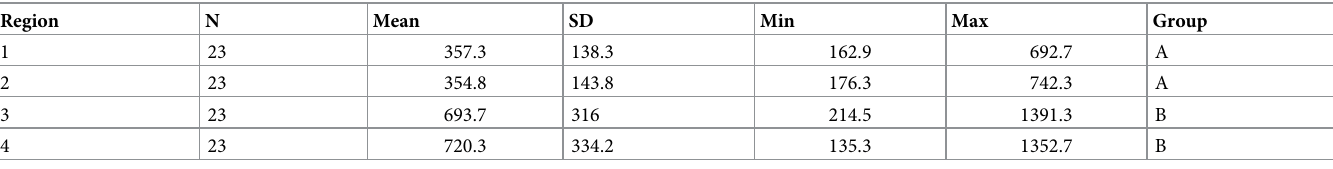
Table 1. Descriptive statistics of BMD in C1. Values of BMD are reported in terms of mg/cm 3 . Region N Mean SD Min Max Group 1 23 357.3 138.3 162.9 692.7 A 23 354.8 143.8 176.3 742.3 A 693.7 316 214.5 1391.3 23 720.3 334.2 135.3 1352.7 B Letters identify statistical